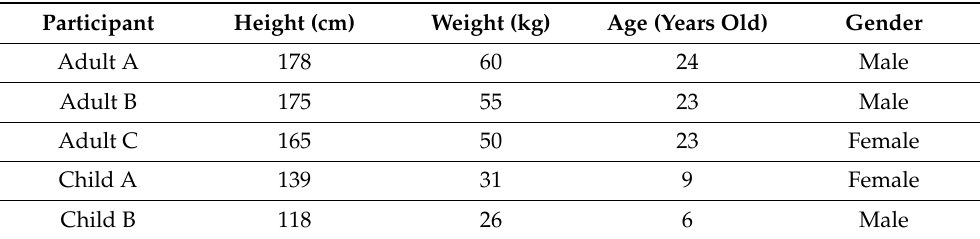
Table 2. Personal information of experiment